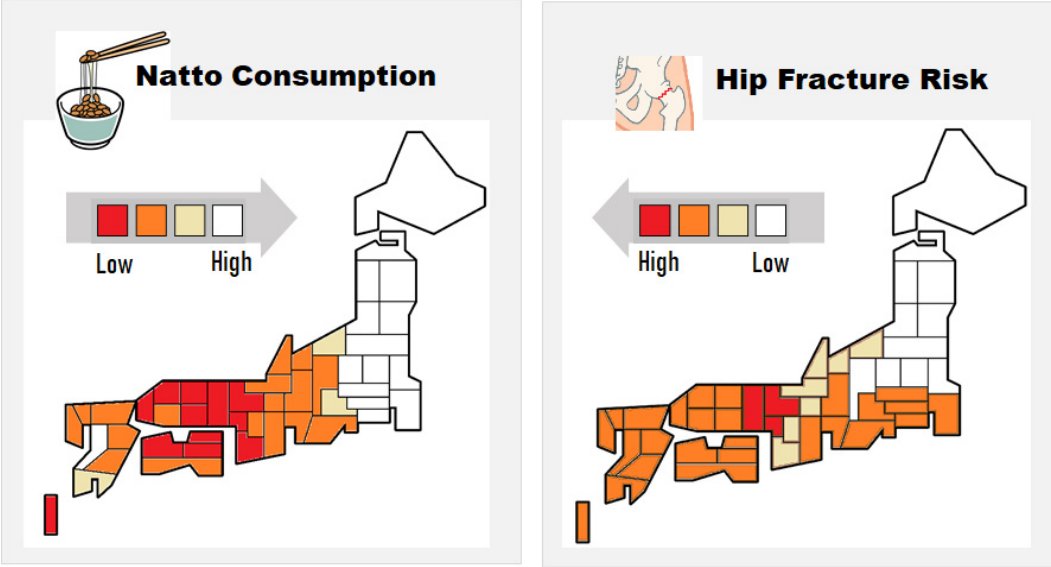
Figure 3. Correlation between the regional relative incidence of hip fractures and natto consumption in Japanese women. Adapted from [42].